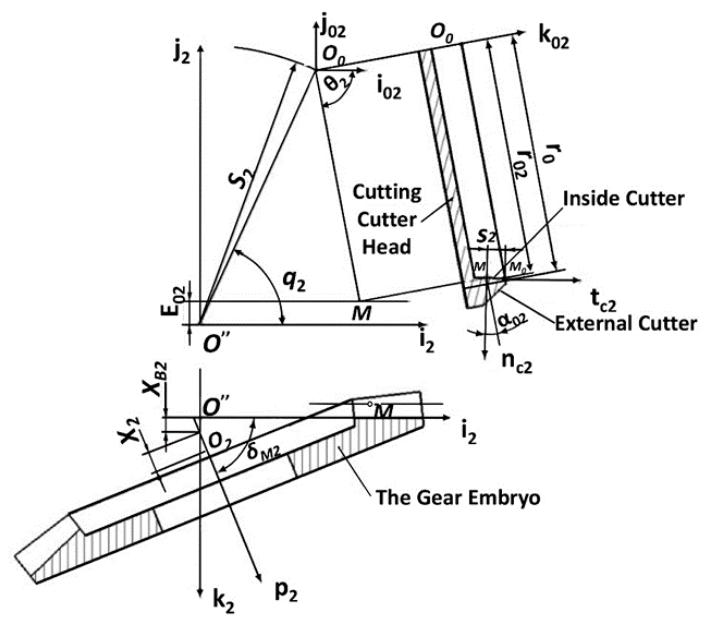
Figure 1. Position relationship between the gear embryo and cutting cutter head.